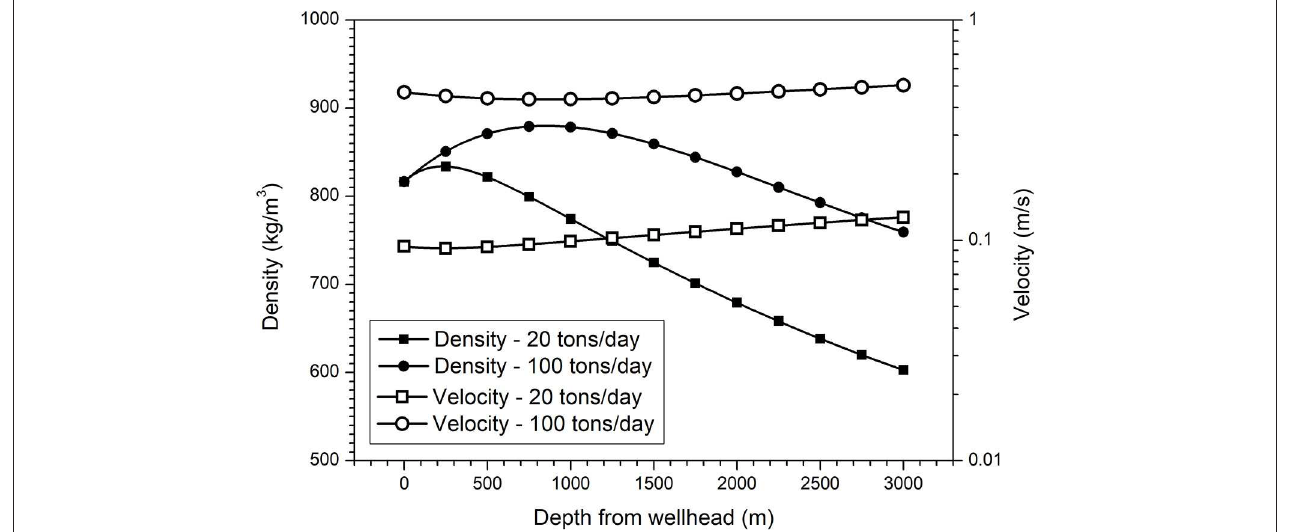
FIGURE 3 | Distribution of density and velocity of CO 2 fluid as a function of well depth at different injection flow rates, which was calculated based on the field condition of an injection well in Shengli oilfield, where the injection temperature and pressure of CO 2 fluid at wellhead were − 20 ◦ C and 10 MPa, respectively (Wang and Song, 2018